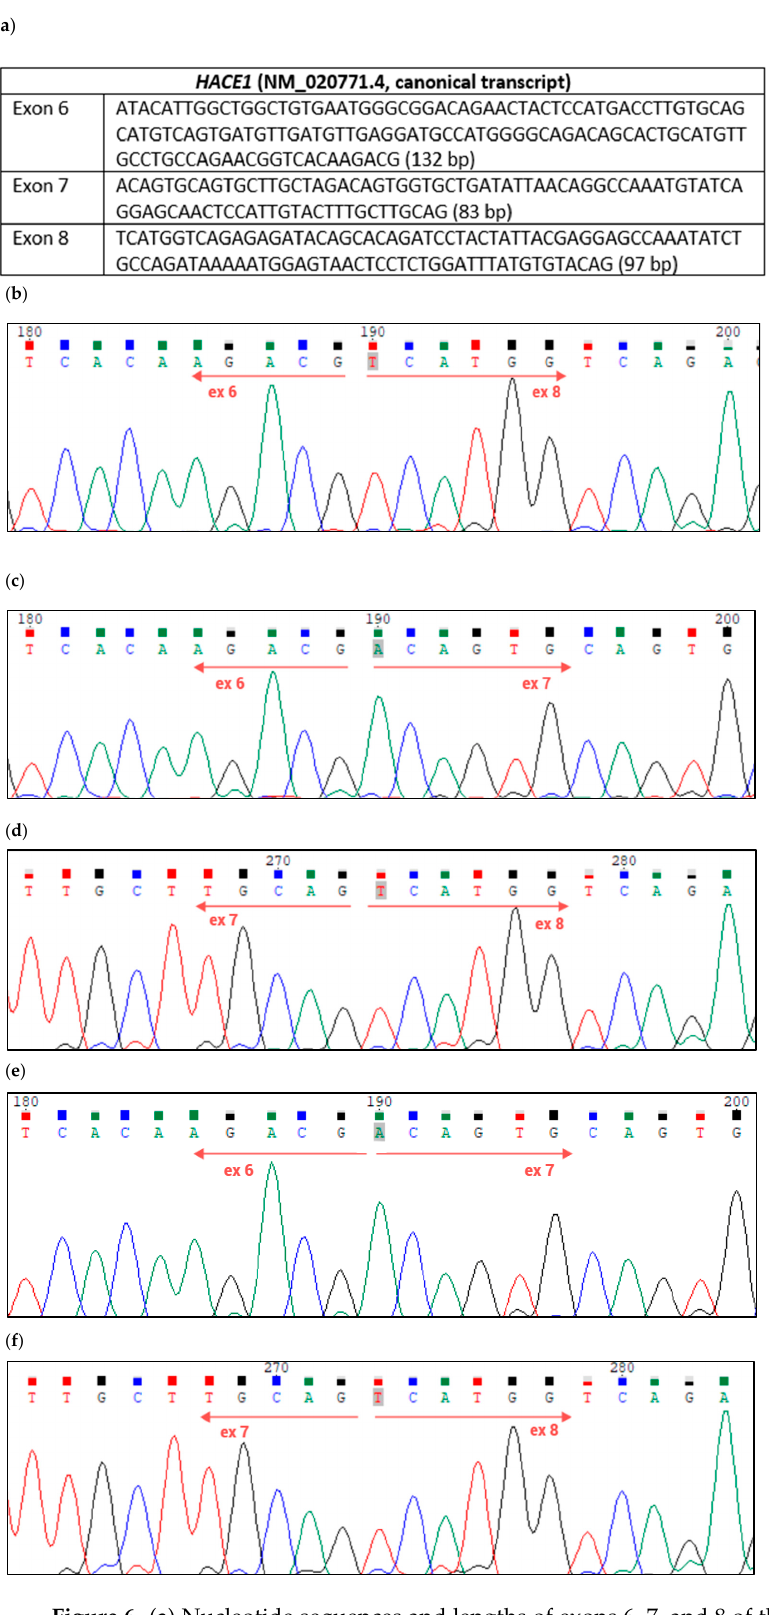
Figure 6. ( a ) Nucleotide sequences and lengths of exons 6, 7, and 8 of the HACE1 gene (canonical transcript); ( b ) Sanger sequencing validation of the homozygous/hemizygous deletion of exon 7 of the HACE1 gene in the proband; ( c , d ) Sanger sequencing of the patient’s mother’s cDNA, validating the presence of exons 6, 7, and 8 of the HACE1 gene; ( e , f ) Sanger sequencing of patient’s father’s cDNA, validating the presence of exons 6, 7, and 8 of the HACE1